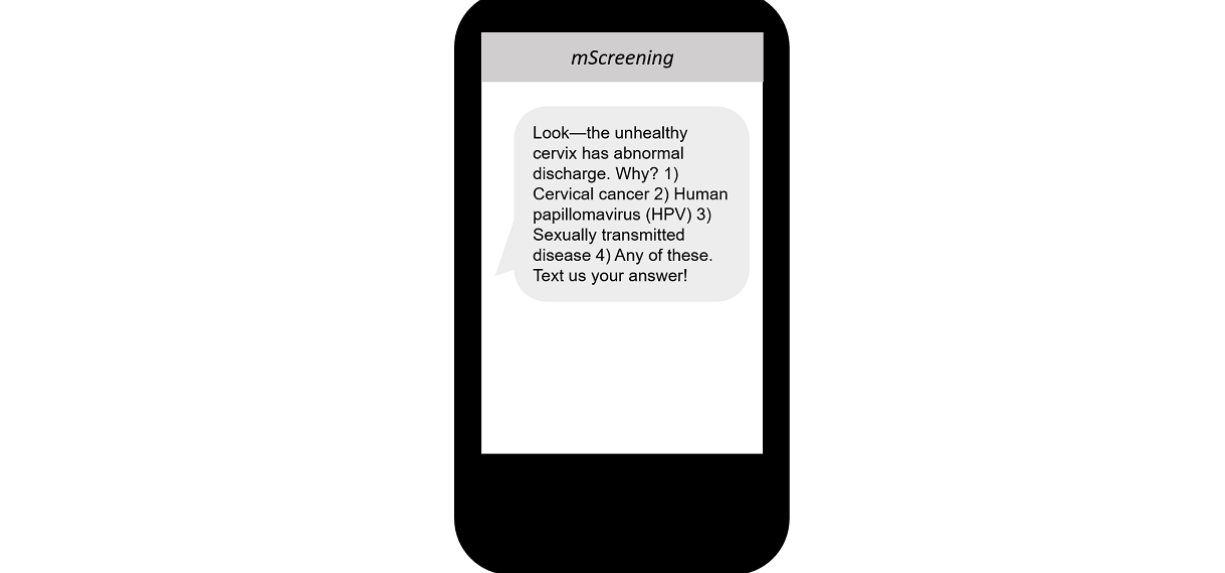
Figure 10. Mobile screening message: developed interactive question and answer